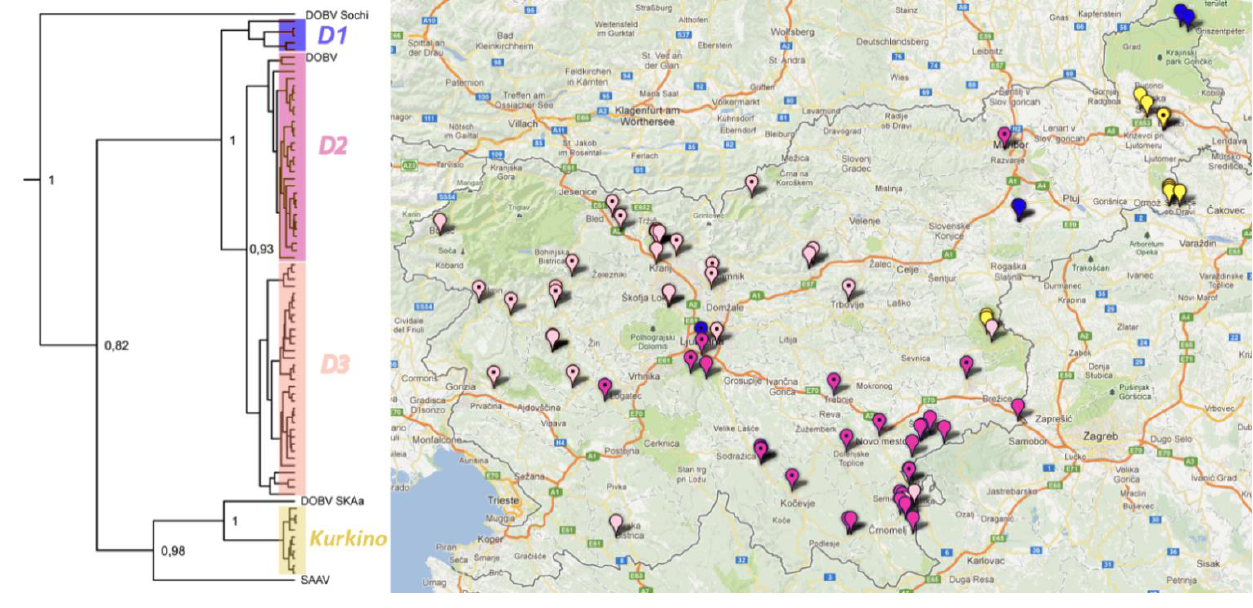
Figure 5. Correlation of phylogenetic and geographical clustering based on sequence of DOBV L segment. Phylogeographic analysis showed the presence of three genetic lineages of DOBV–Dobrava (violet—D1, pink—D2, orange—D3) and DOBV– Kurkino genotype in mice and patients. The sequences obtained from patients are marked with a